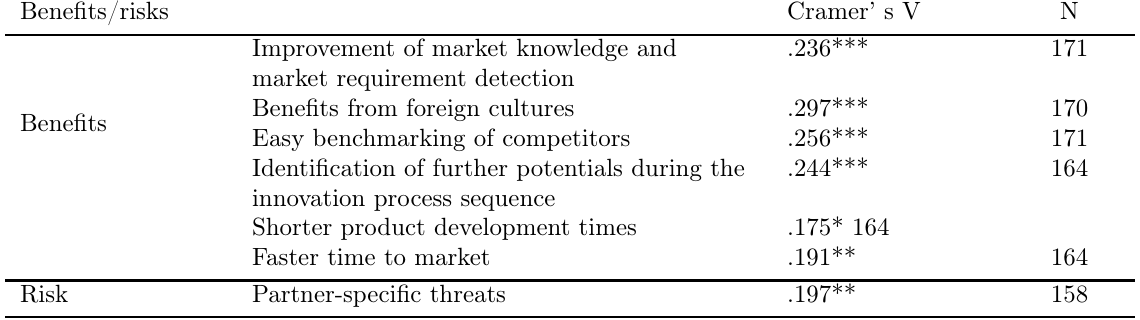
Table 8. Correlations between benefits/risks and enterprise